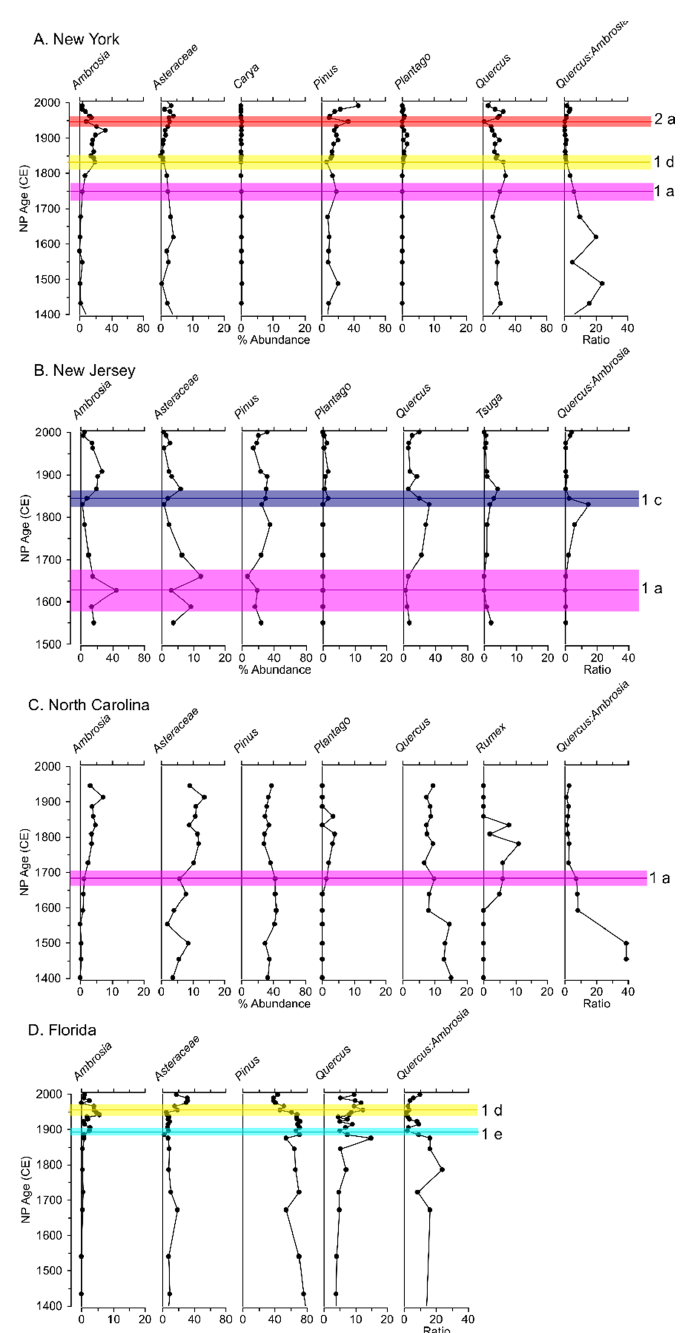
Figure A1. Pollen stratigraphic diagrams for published data plotted against the NP Bchron predicted ages to compare the age plus uncertainty of the pollen chronohorizons with the ages derived from other age markers at the depth where the pollen chronohorizon occurred for New York ( A ), New Jersey ( B ), North Carolina ( C ), and Northern Florida ( D ). Colored lines indicate the pollen chronohorizons; colored shading indicates the uncertainty associated with each pollen chronohorizon. The colors refer to Figure 3. The chronohorizons are as follows: (2a) reforestation; (1d) beginning of the forestry industry; (1a) initial land clearance; (1c) lowest amount of forest cover; and (1e) railroad expansion (Table